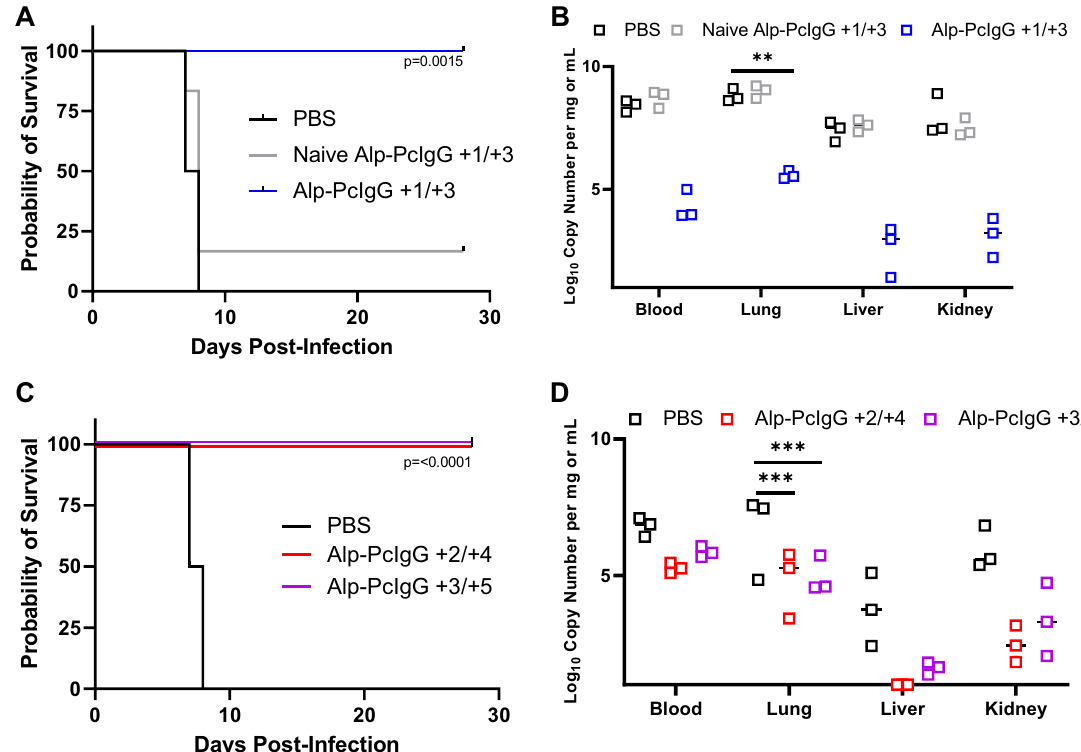
Figure 3. Survival and ANDV RNA levels in Alp-PcIgG-ANDV treated Syrian hamsters. Syrian hamsters were infected with 154 FFU of ANDV and treated with either PBS, purified naïve alpaca IgG, or ANDV-specific Alp-PcIgG at different time points post-infection. ( A ) Survival curve following ANDV infection and indicated treatment on days + 1/ + 3 with respect to ANDV challenge. ( B ) Viral RNA levels in blood and tissues of treated or mock-treated (days + 1/ + 3, with respect to challenge), ANDV infected hamsters. ( C ) Survival of hamsters treated at extended time points (days + 2/ + 4 or days + 3/ + 5, with respect to ANDV challenge) with ANDV- specific Alp-PcIgG or PBS. ( D ) Viral RNA levels in the blood and tissues of treated (days + 2/ + 4 or days + 3/ + 5, with respect to ANDV challenge) and untreated ANDV infected hamsters. For ( A ) and ( C ), n = 6 per group. For B and D, n = 3 per group euthanized on the day post-infection when control animal met the criteria for euthanasia. For ( A ) and ( C ), significance assessed by Log-rank (Mantel-Cox) test. For ( B ) and ( D ), significance was assessed by two-way analysis of variance. ** = p < 0.01, *** = p <